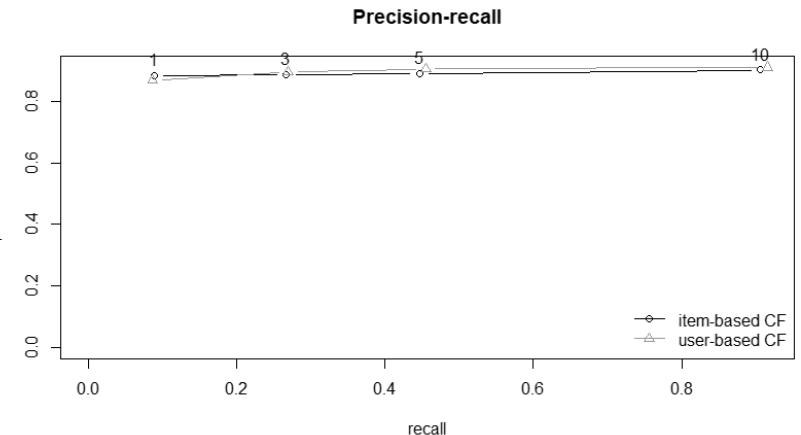
Figure 3. Comparison of precision–recall curves for item- and user-based recommender methods; precision represents correctly recommended items divided by total recommended items; recall represents correctly recommended items divided by total useful recommendations.